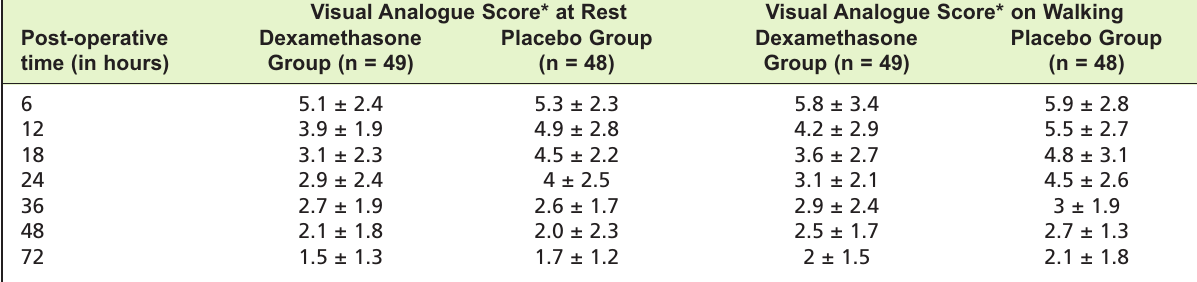
Mean Visual Analogue Scores at Rest and on walking after anterior cruciate ligament reconstruction Table II: Visual Analogue Score* at Rest